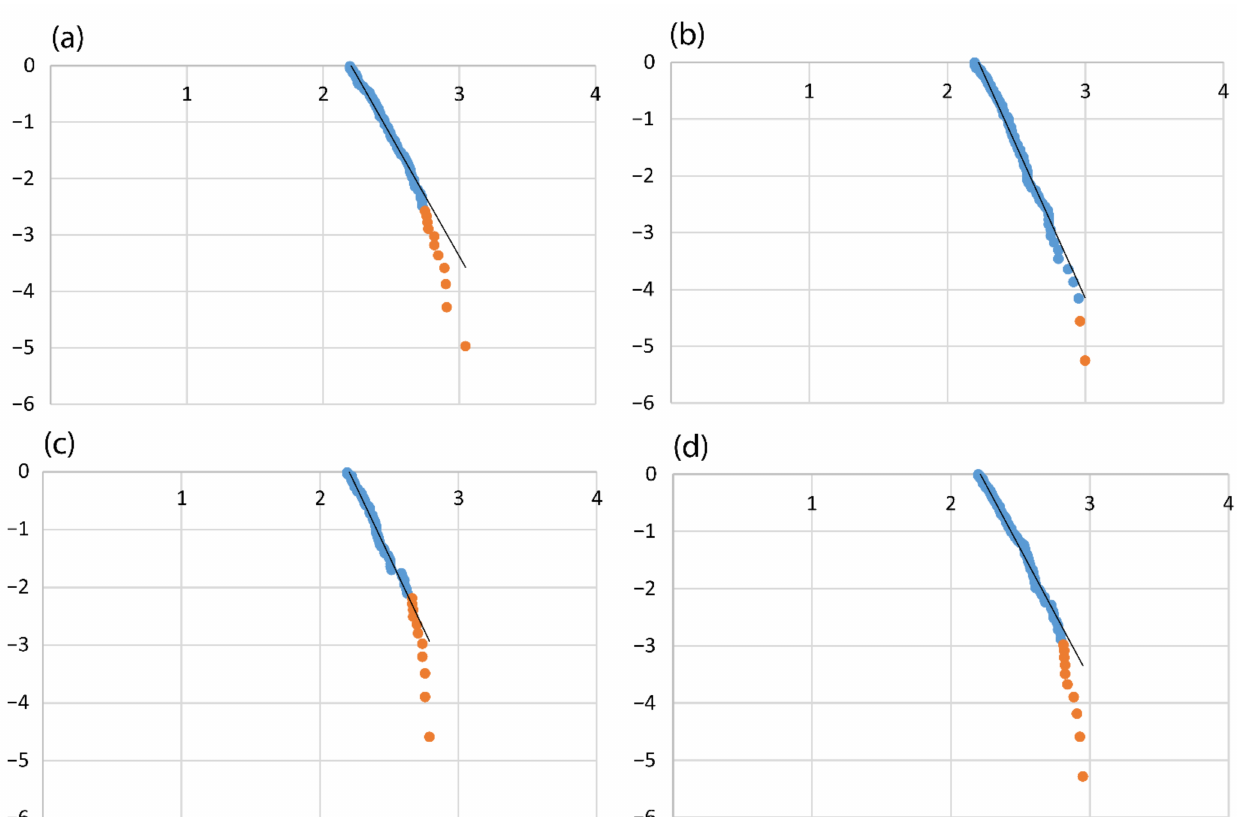
Figure 3. The CDFs of daily precipitation amounts (ERA5 data) straightened on the coordinate axis of the Pareto distribution, and linear regression line corresponding to the Pareto function: ( a ) 75 N, 24 E (the lower points on the chart correspond 10 January 2019 and 30 November 2019); ( b ) 74 N, 33 E (the lower point on the chart corresponds 30 November 2019); ( c ) 74 N, 41 E (the lower point on the chart corresponds to 30 November 2019, 5th bottom point on the chart corresponds to 19 January 2000; ( d ) 73 N, 31 E (the lower point on the chart corresponds 6 January 2009). In all cases R 2 > 0.98 for basic distribution (blue dots). The yellow dots are deviations from the Pareto function (the so-called “dragons”). CDFs discussed below (see text).